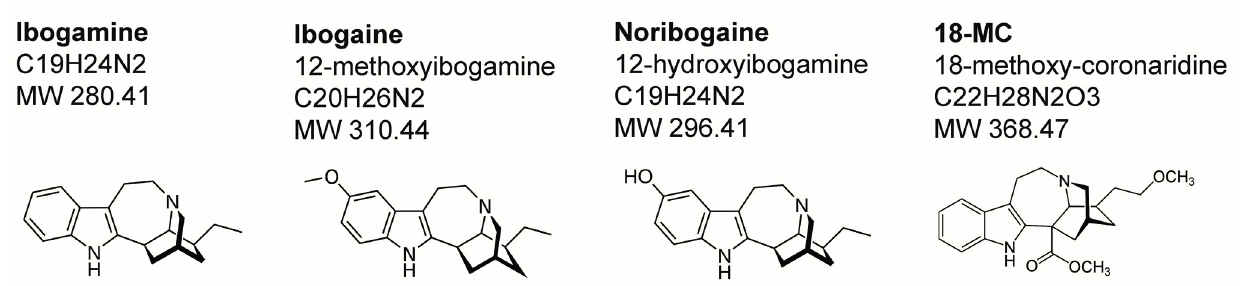
Figure 1. Strucures of ibogamine, ibogaine, noribogaine, and 18-MC with respective full names, chemical formula, and molecular weight